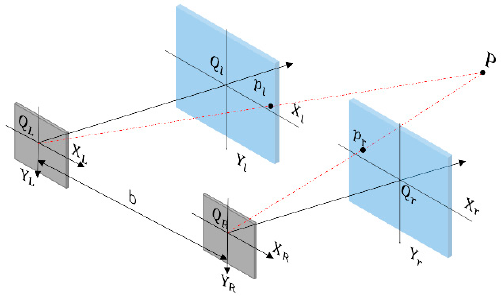
Figure 8. Schematic diagram of the image depth calculation.